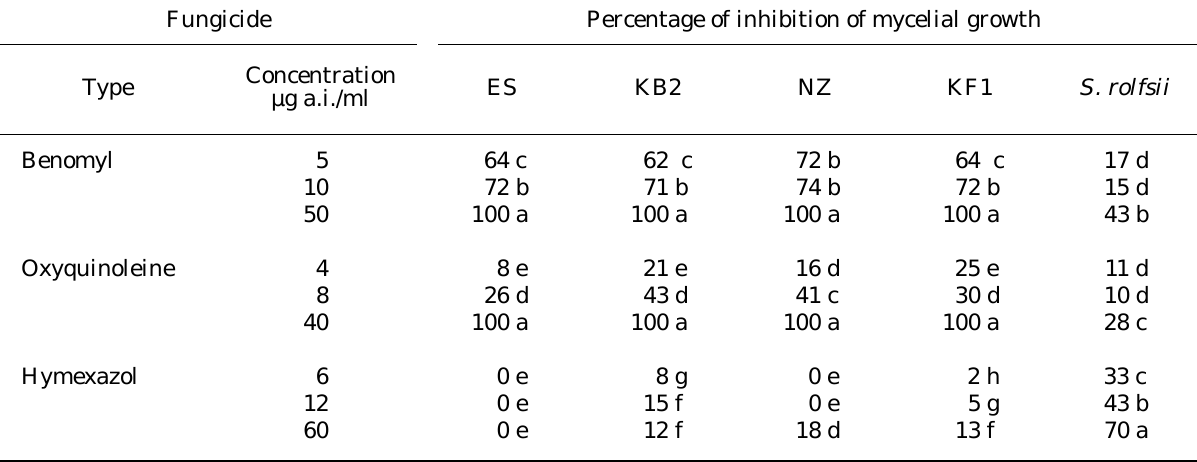
Table 2. Effect of fungicides on the mycelial growth of Trichoderma harzianum isolates (ES, KB2, NZ, KF1) and Sclerotium rolfsii on PDA incubated at 28 (cid:176) C for 48